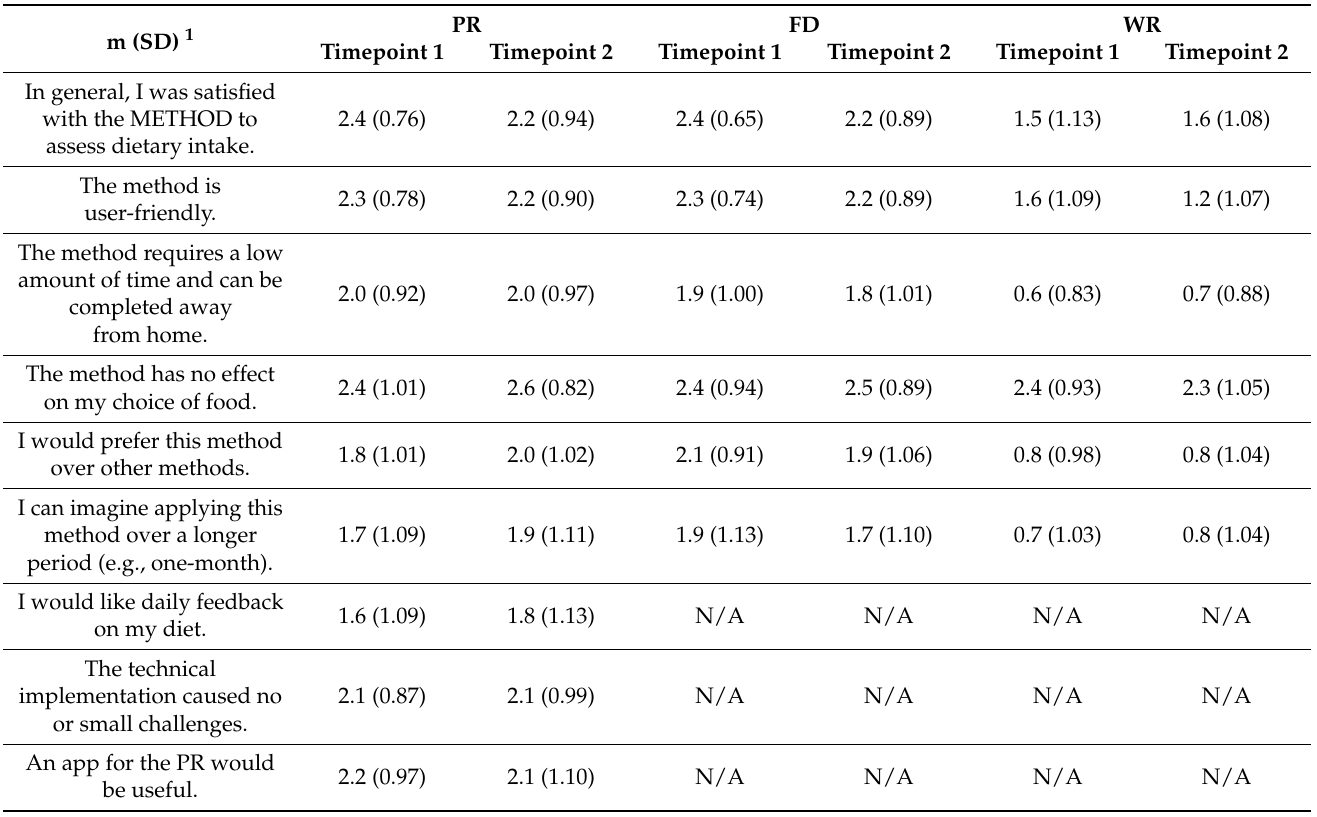
Table A3. Participant responses in the satisfaction survey for the different assessment